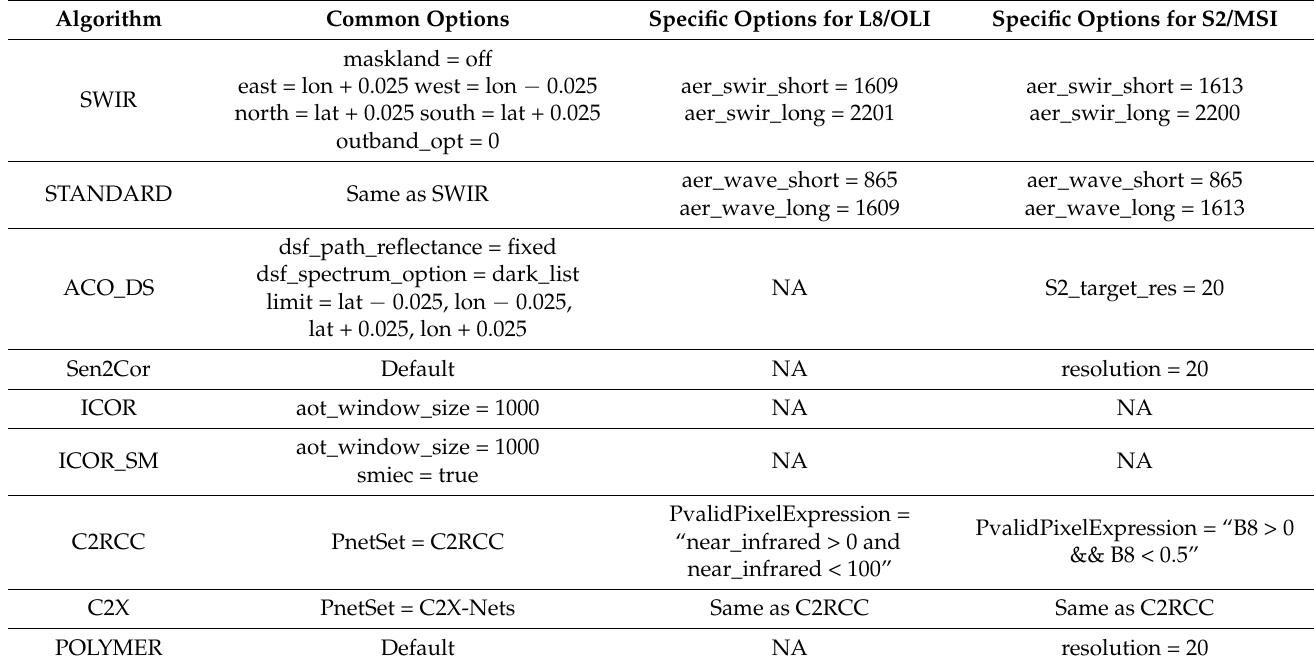
Table 2. Specific options of nine water-specific AC algorithms for L8/OLI and S2/MSI image processing. LaSRC options are not listed, the R rs spectra were obtained directly from GEE instead of processing the L1 images of